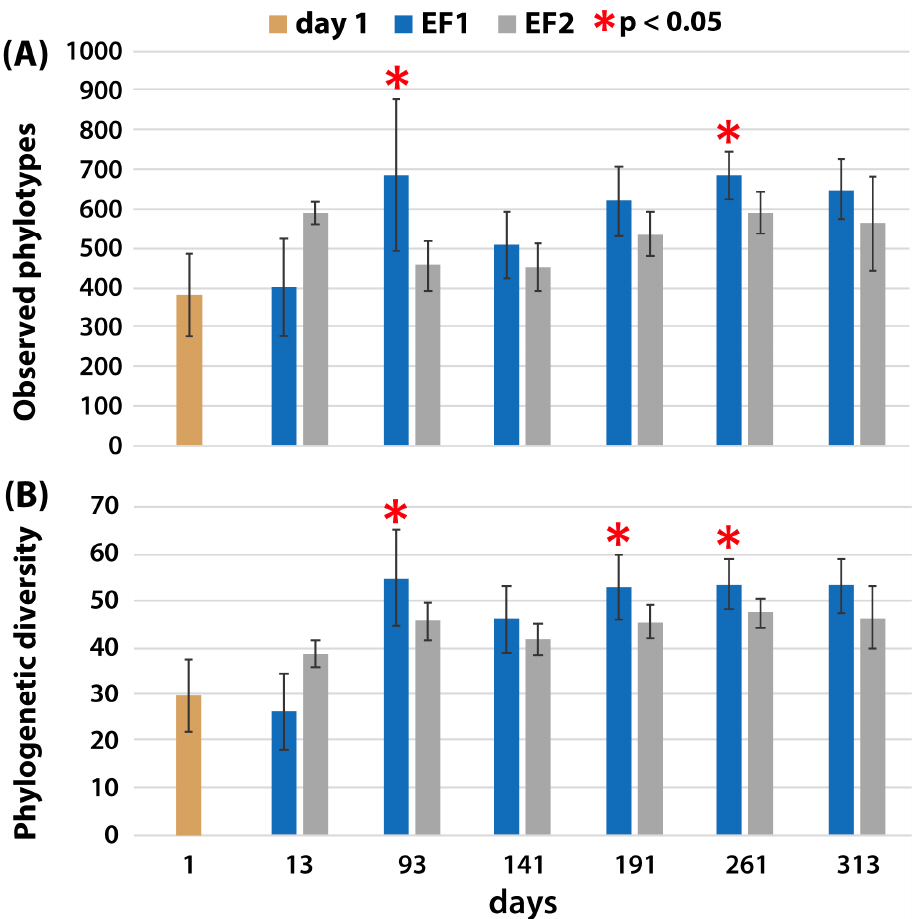
Figure 2. Alpha diversity indices of (A) observed phylotypes and (B) phylogenetic diversity. Red asterisks indicate statistical difference between Experimental Fields (EF) 1 and EF2 based on Welch’s t ‐ test ( p < 0.05).